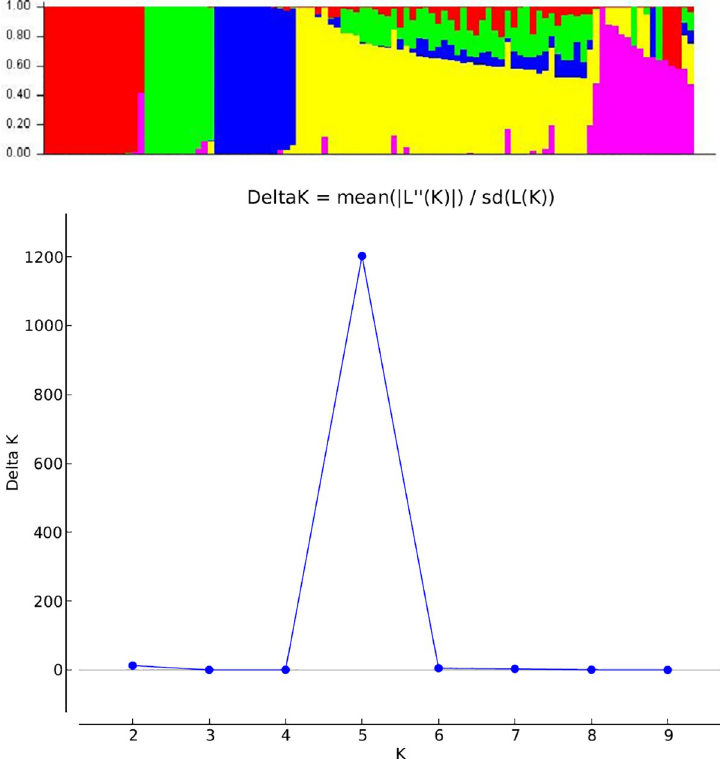
Fig 4. a. Population structure bar plot of the inbred lines showing five sub-populations of the 103 extra-early QPM/ Provitamin A inbred. b. A graph showing of the best K with the Evanno method used to group the inbred lines into sub-populations at k =